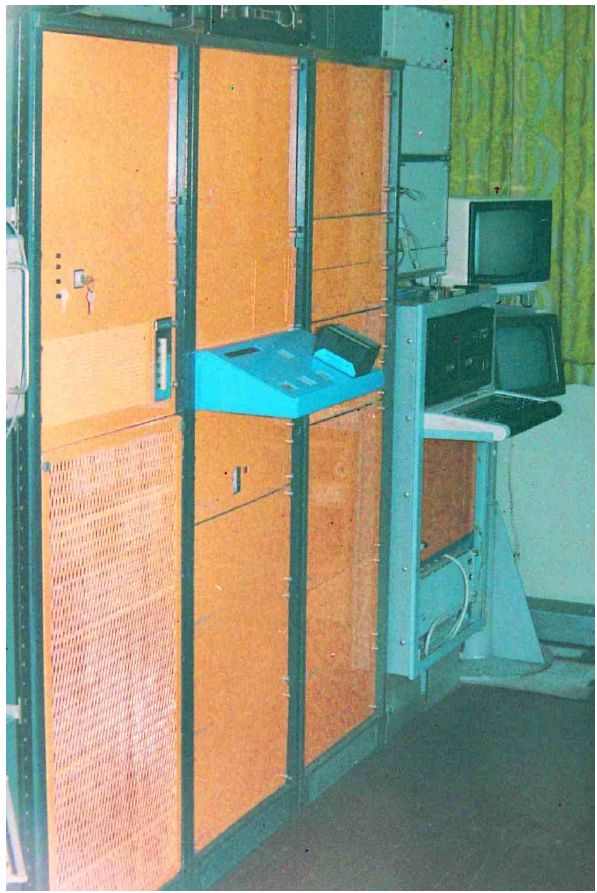
Figure 40. Loop antenna clamped on a wooden stake.